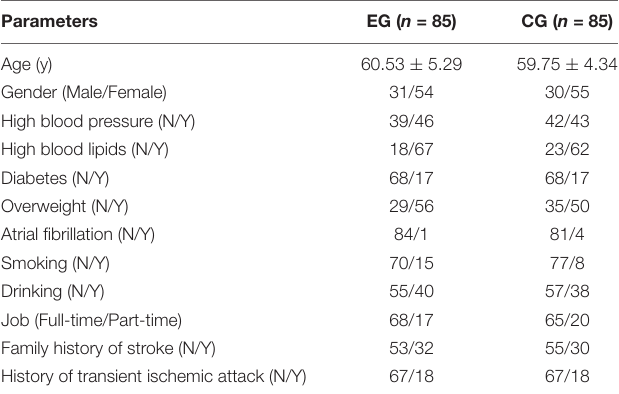
TABLE 1 | Clinical baseline characteristics between two